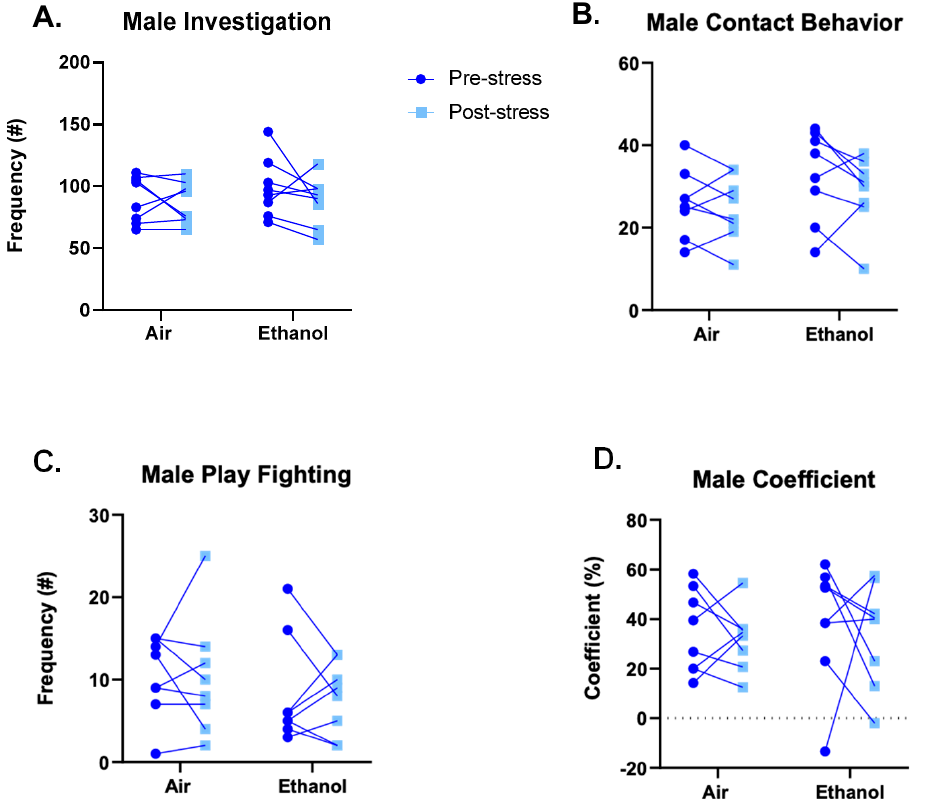
Figure 4. Frequencies of male social interaction behaviors, namely investigation ( A ), contact behaviors ( B ), play ‐ fighting behaviors ( C ), and social preference/avoidance coefficient ( D ), compared between adolescent ethanol or air exposure and 24 h before and after two days of FSS. There were no significant effects of ethanol or stress for any measure in males.